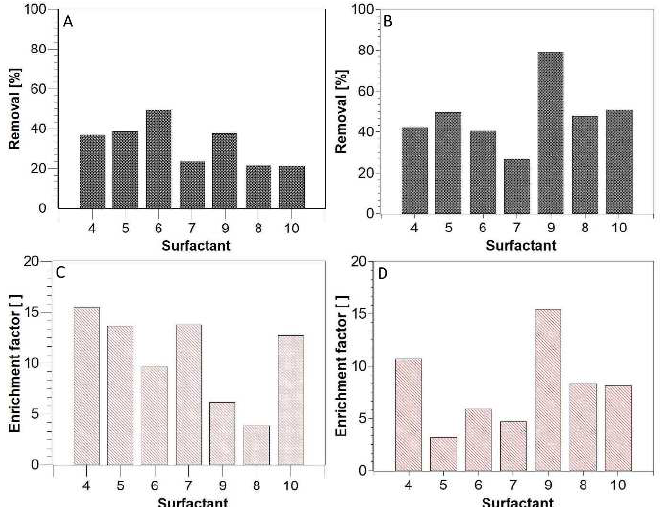
Figure 4. Flotation results of conventional and carbonate-modified nonionic surfactants (surfactant numbers are shown in Table 1). Conditions: 300 µ m PET particles. Initial conc.: 750 mg/L.